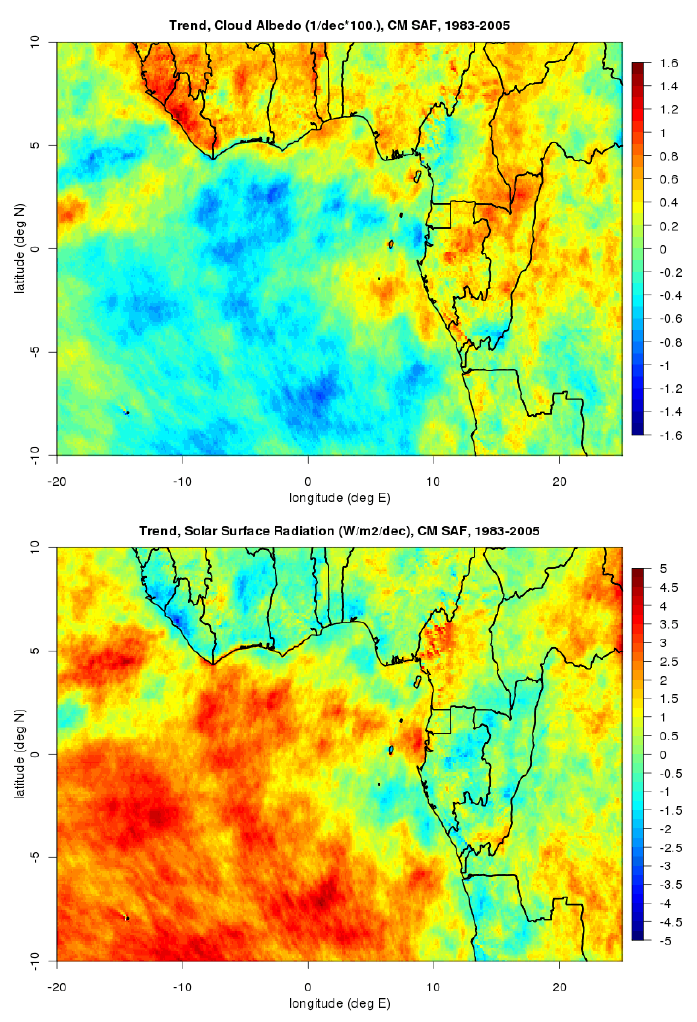
Figure 9. Trend of the effective cloud albedo and the solar surface irradiance within the ITCZ. The slightly different trends apparent in the CAL and SSI (Top , Bottom) are a result of trends in water vapour affecting SSI but not